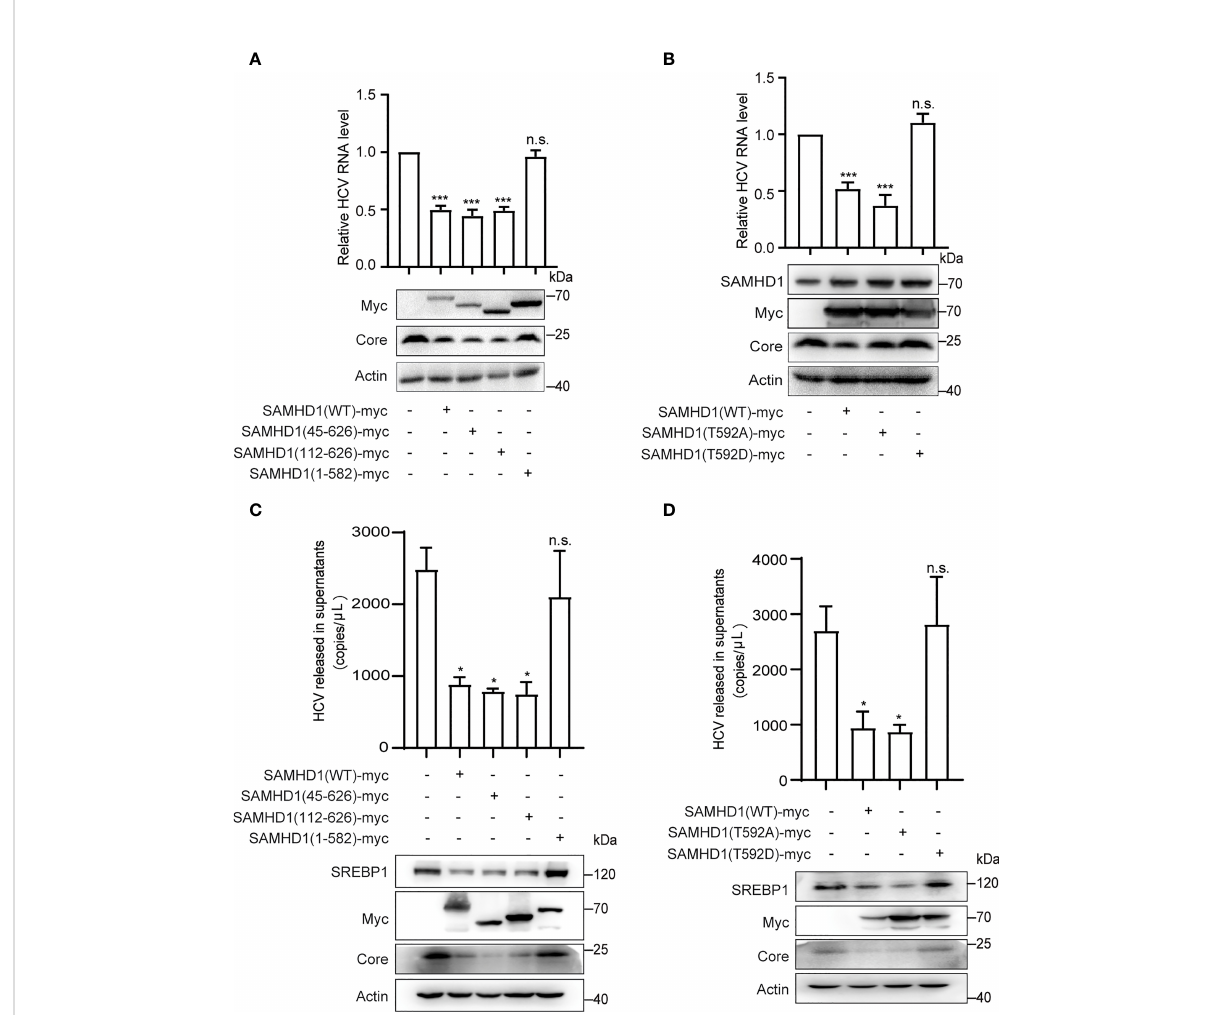
FIGURE 5 The C-terminus of SAMHD1 is essential for its anti-HCV activity. (A, B) Normal Huh7.5.1 cells were respectively transfected with plasmids expressing SAMHD1 truncations [SAMHD1(45 – 626), SAMHD1(112 – 626), and SAMHD1(1 – 582)] (A) or SAMHD1 mutants [SAMHD1(T592A) and SAMHD1(T592D)] (B) , and followed by infection with JFH1 HCVcc for 48 h. Cell lysates were examined by Western blotting to determine the expression of SAMHD1 and HCV proteins. Replication levels of HCV RNA in infected cells were isolated and quanti fi ed by qRT-PCR. (C, D) SAMHD1-KO Huh7.5.1 cells were respectively transfected with plasmids expressing SAMHD1 truncations [SAMHD1(45 – 626), SAMHD1(112 – 626), and SAMHD1(1 – 582)] (C) and SAMHD1 mutants [SAMHD1(T592A) and SAMHD1(T592D)] (D) and infected with JFH1 HCVcc for 48 h. HCV RNA in culture medium was isolated and quanti fi ed by qRT-PCR. Cells were harvested for detection of protein expression by Western blotting. All data are representative of three independent experiments and shown as mean ± SD. ns, not signi fi cant; *P<0.05, and